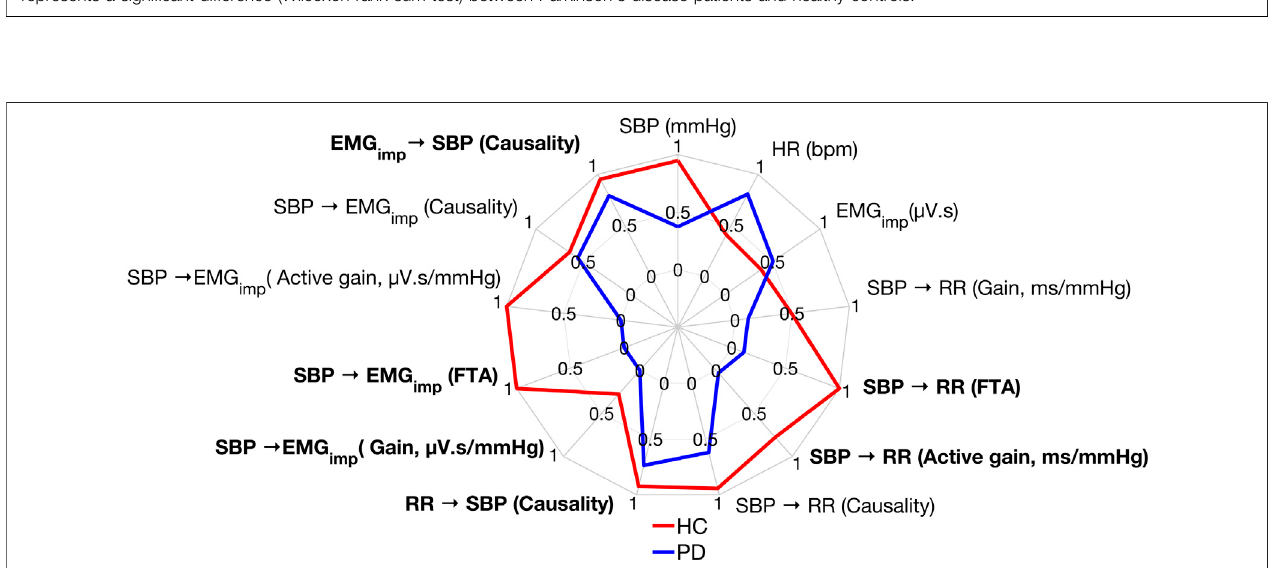
FIGURE 7 | Comparison of the response variables calculated in this work between a Parkinson ’ s patient and a healthy control participant during standing. Data were normalized between 0 and 1 for better visualization of the results. A value of 0, 1 signi fi es the worst, best performance, respectively. Bolded text indicates a signi fi cant difference between Parkinson ’ s patients and healthy controls during